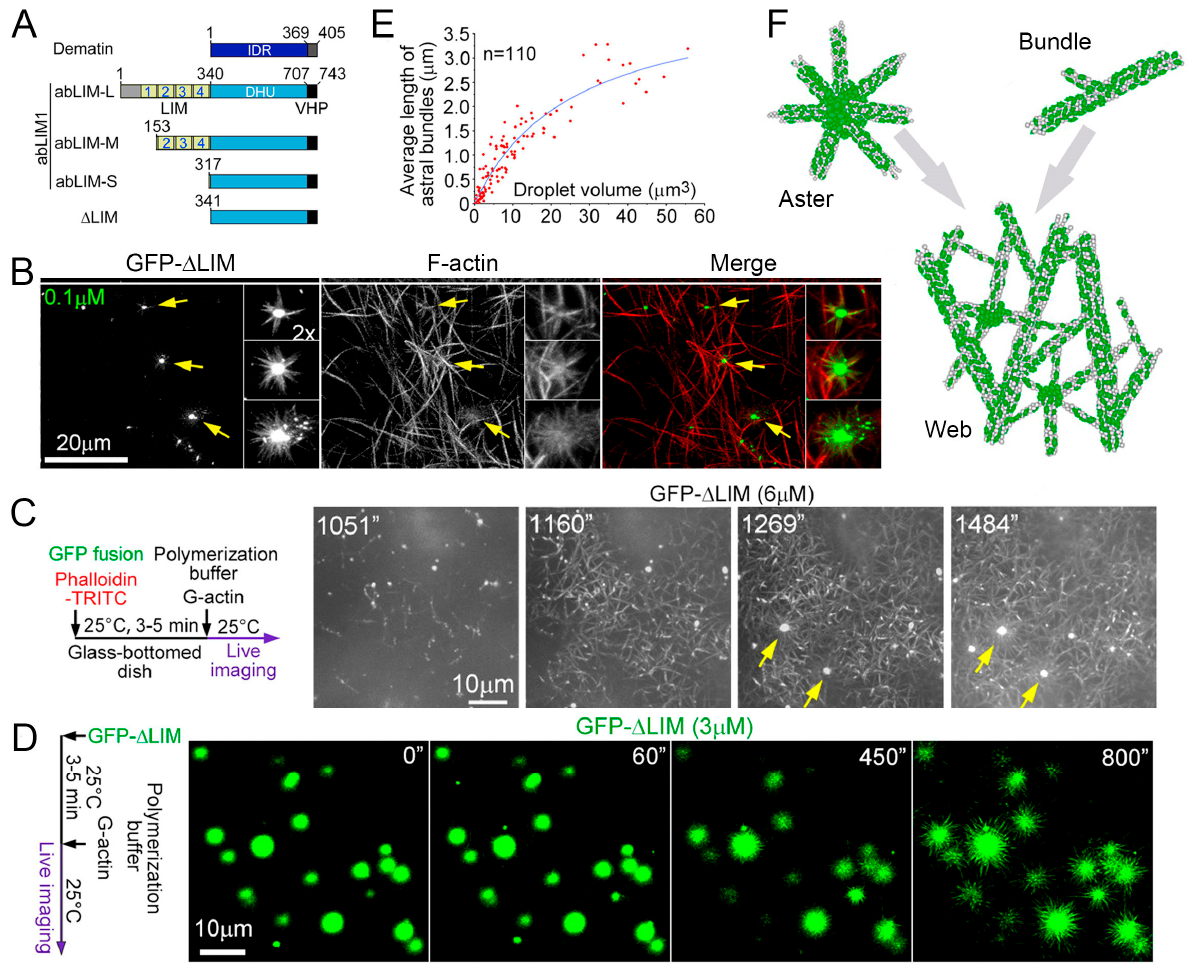
Figure 2. Δ LIM induces asters and webs of F-actin bundles in vitro. ( A ) Isoforms of human abLIM1. ( B ) Effects of GFP- Δ LIM on F-actin organizations in vitro. Arrows indicate representative astral structures. This presents the results of experiments in which the GFP- Δ LIM concentration was 0.1 μ M. ( C ) The scheme of the experiment and the results of live imaging. The final concentration of G-actin was 6 μ M. Phalloidin-TRITC (final concentration: 4 μ M) was used to label F-actin. Representative time-lapse images showing the formation of His-GFP- Δ LIM-induced actin webs. Z-stack images, at 1 μ m intervals, were captured for the GFP autofluorescence to cover a depth of 6 μ m close to the bottom of the substratum via spinning disk microscopy at ~3.6 s intervals. The time started immediately after the addition of G-actin. Arrows denote two asters integrated into the web. ( D ) Massive actin polymerization from liquid droplets of GFP- Δ LIM. The experiments were performed without phalloidin-TRITC to show that the aster formation was not due to the presence of phalloidin. ( E ) Positive size–length correlations between the GFP- Δ LIM droplets and astral F-actin bundles. The size (volumes) of each droplet and the mean length of its astral bundles were measured from time-lapse images. ( F ) Illustrations showing Δ LIM (green)-induced F-actin-based asters, bundles, webs, and their relationships. The figure represents panels A of Figure 1; line 5 of panel B; panels E, F, and H of Figure 2; and panels A and C of Figure 4 from Yang et al., PNAS 119 (29), e2122420119